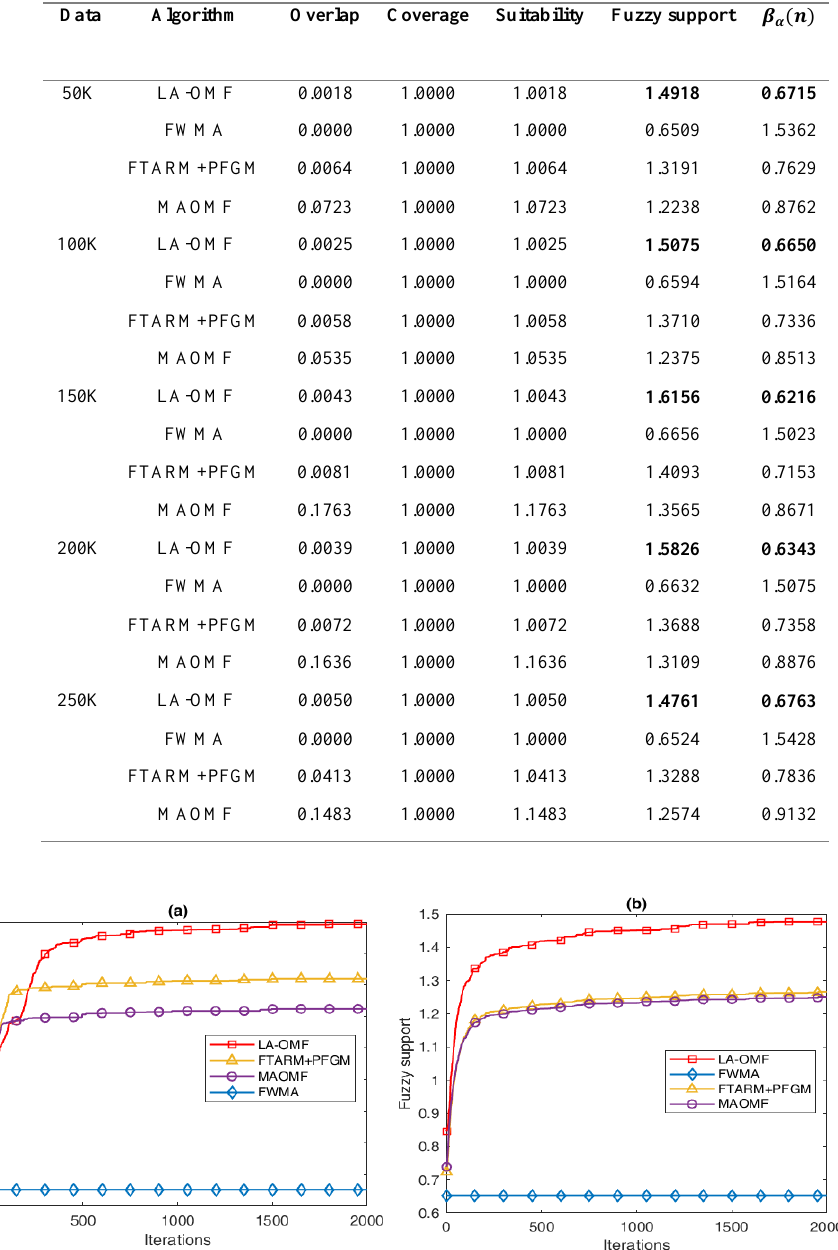
Table 7. Comparison of the results acquired from LA-OMF and FWMA on the data of different sizes.